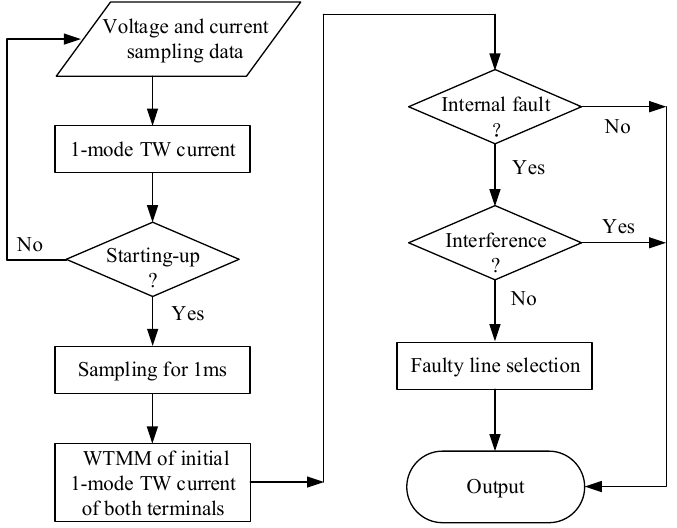
Figure 13. Flow chart of protection scheme.